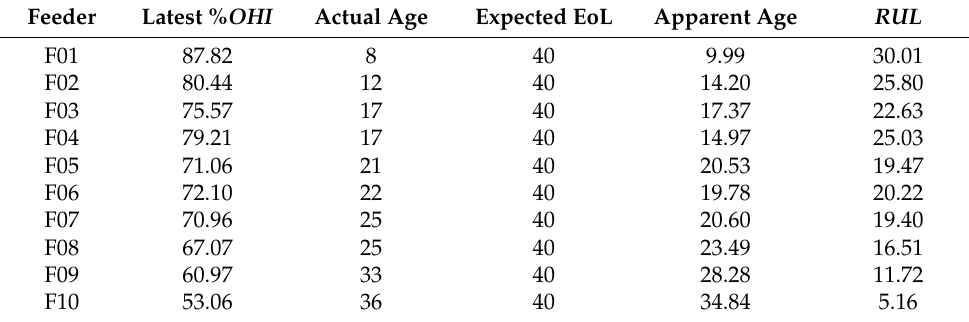
Table 8. RUL estimation of 10 in-use systems in the same estate area.